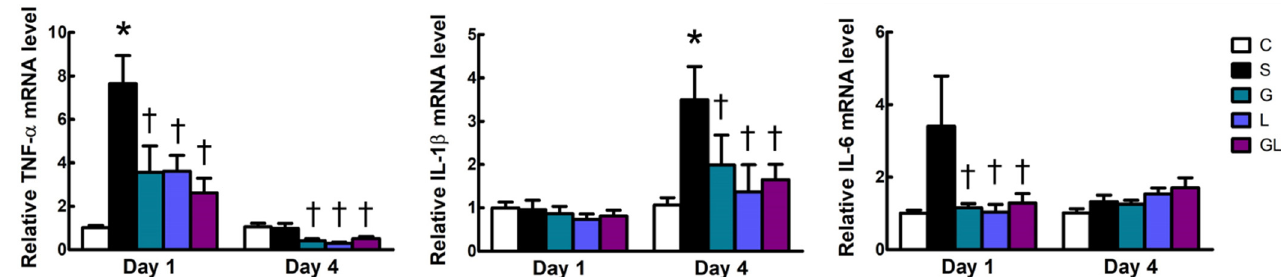
Figure 4. Muscle mRNA expressions of inflammatory genes. The groups are described in the legend to Table 1, and gene abbreviations are given in the footnotes to Table 2. Student’s t -test was used to analyze differences between the C and S groups at the same time point. Differences among septic groups on the same day were analyzed by a one-way ANOVA with Tukey’s post-hoc test. * Significantly differs from the C group. † Significantly differs from the S group ( p < 0.05).